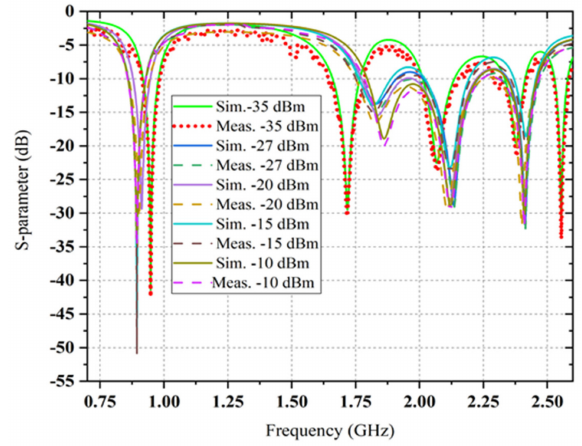
Figure 17. The comparison between simulated and measured scattering parameters of the suggested multiband rectifiers at six available ambient input RF power density levels for a constant load of 6.81 k Ω .